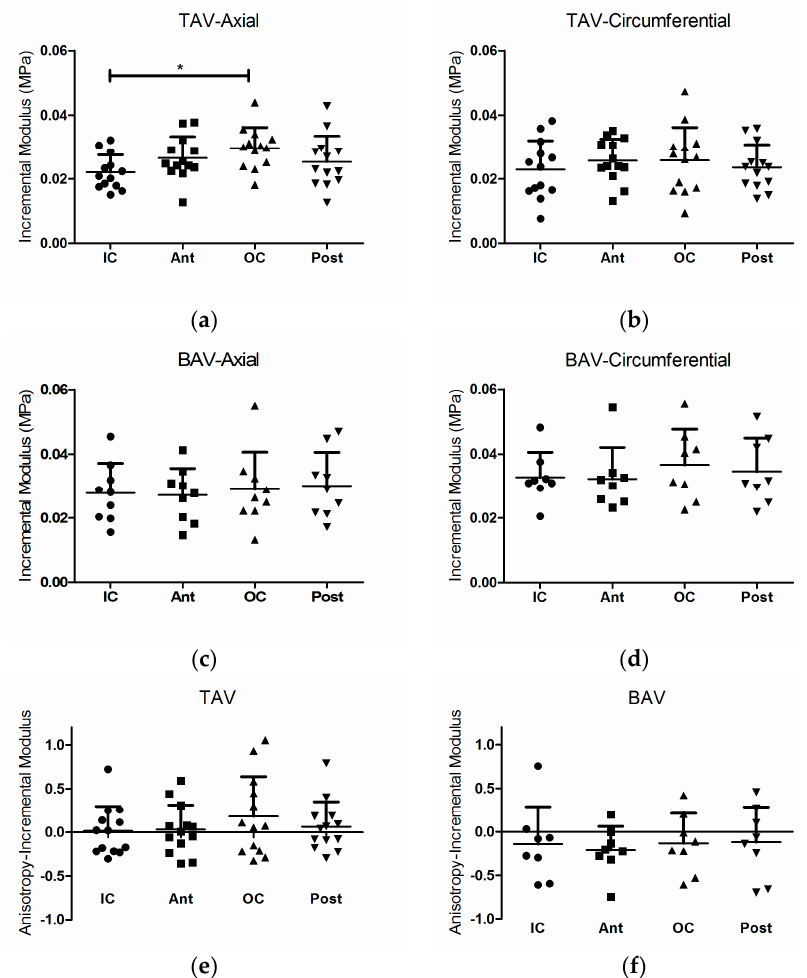
Figure A1. Variation of incremental modulus: ( a ) axial and ( b ) circumferential directions of the TAV group, and ( c ) axial and ( d ) circumferential directions of the BAV group, and anisotropy of the incremental modulus for the ( e ) TAV and ( f ) BAV groups. Only the axial modulus of the TAV group shows dependency on the region ( p = 0.0305) (one-way ANOVA with repeated measure and Bonferroni’s multiple comparisons post-test). Asterisk denotes significant difference: * p < 0.05.